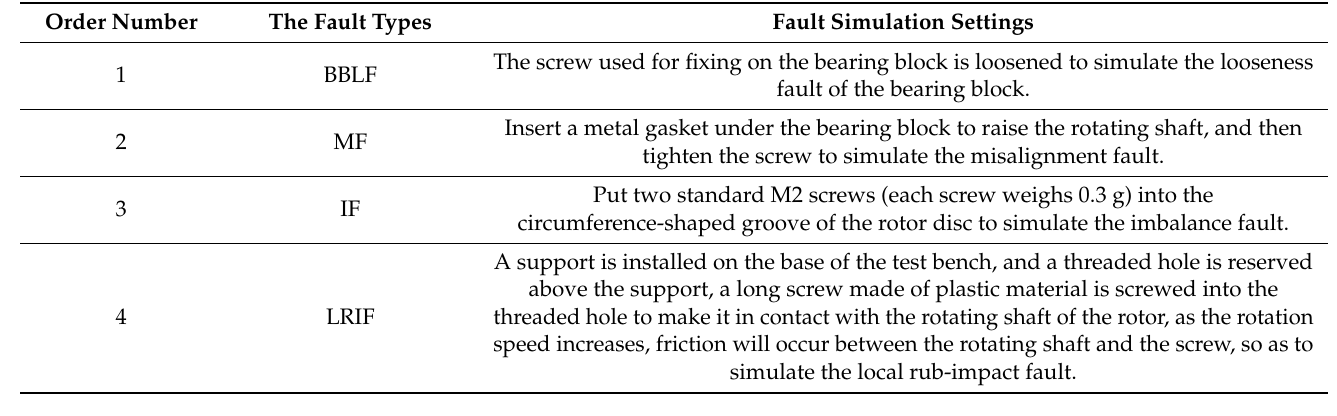
Figure 4. ZT-3 rotor fault simulating experimental device. Table 2. Equipment list of the experiment. Table 3. The fault simulation settings.